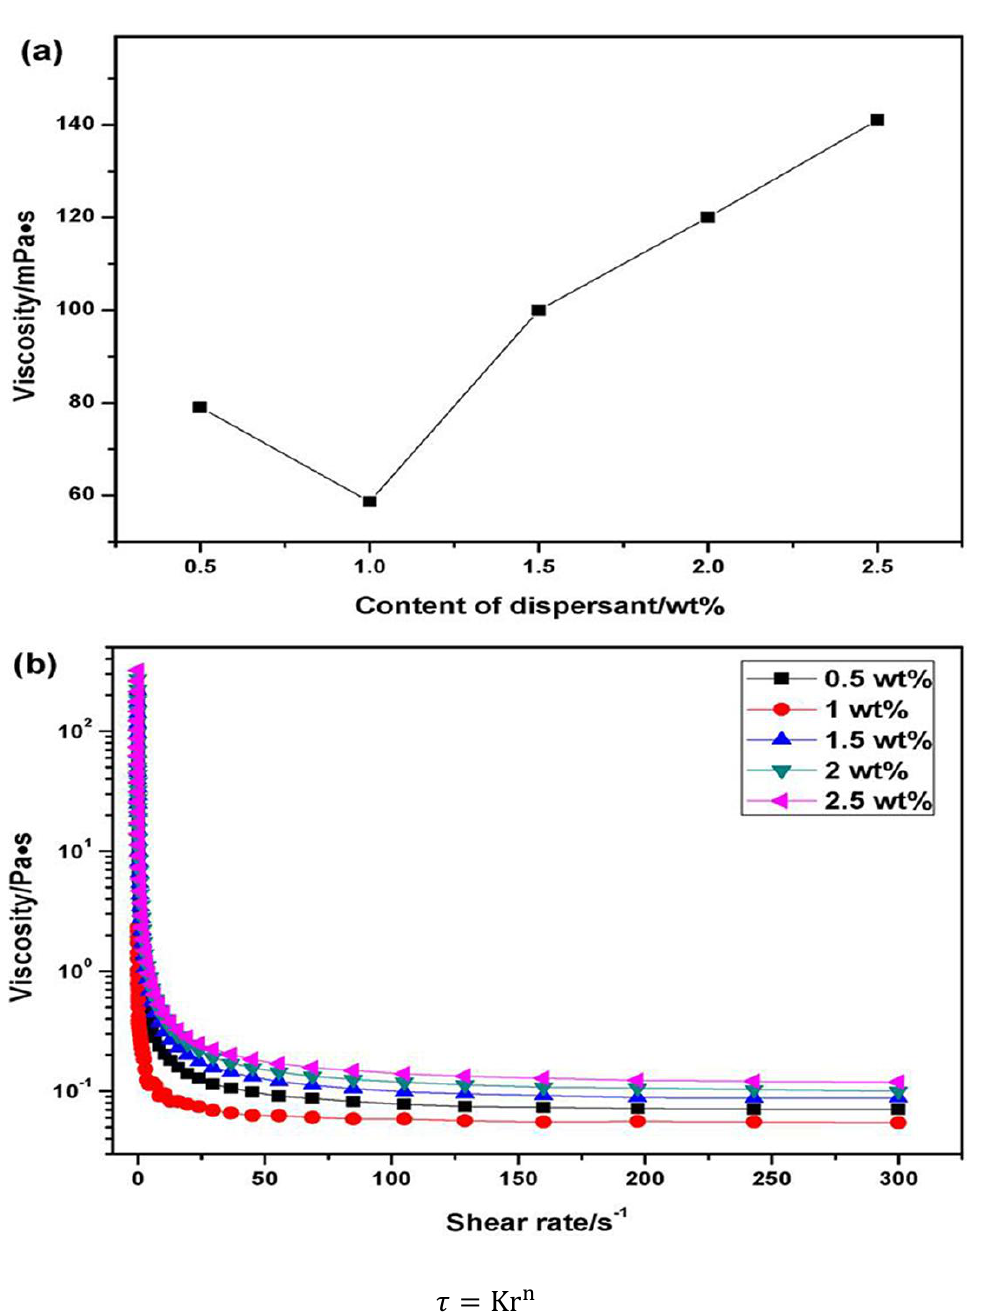
Figure 5. Effect of dispersant content on: ( a ) the viscosity at 100 s −1 and ( b ) rheological behavior of 30 vol % ZSB suspensions (pH